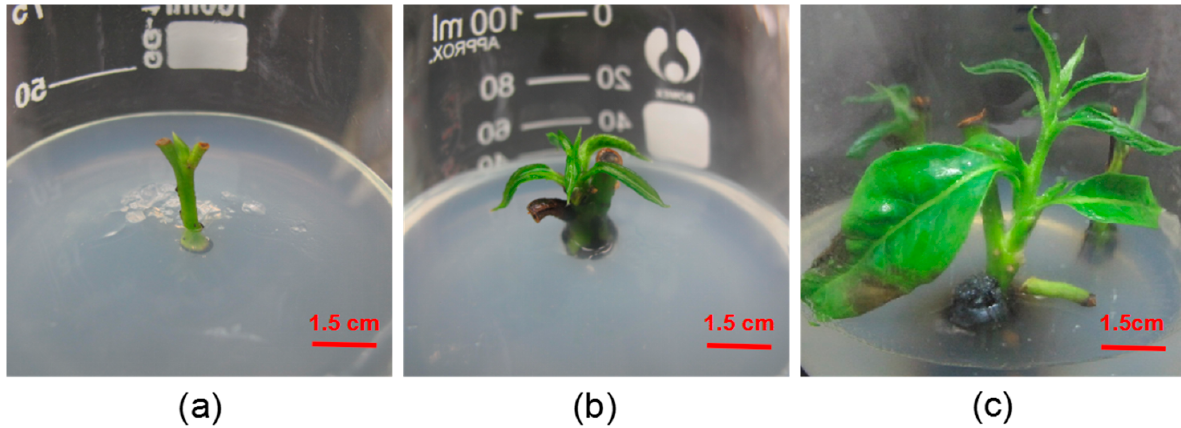
Figure 1. Growth status of the axillary buds of D. lotus . ( a ) Stem with buds inoculated in culture medium after 7 days. ( b ) Stem with buds grows leaves after 15 days. ( c ) Stem with buds growing to 3 cm in 25 days.